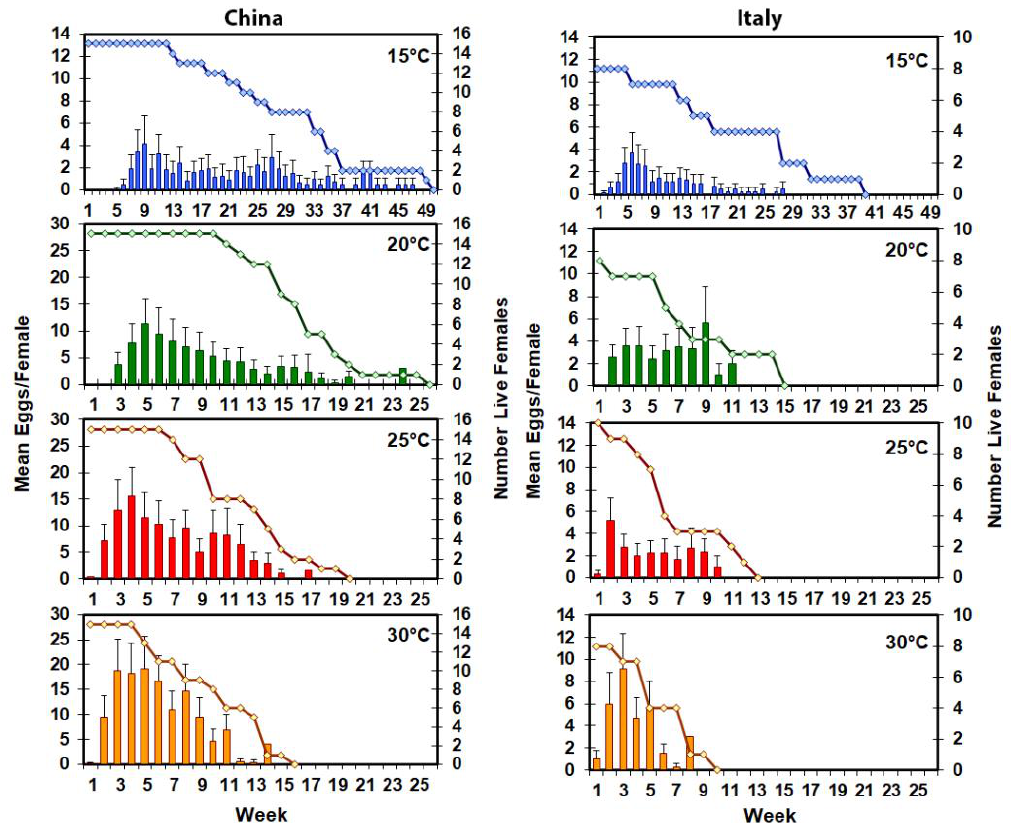
Figure 2. Mean ( ± SE) weekly oviposition and female survival for female A. chinensis from China (Left) and Italy (Right) held at four constant temperatures.